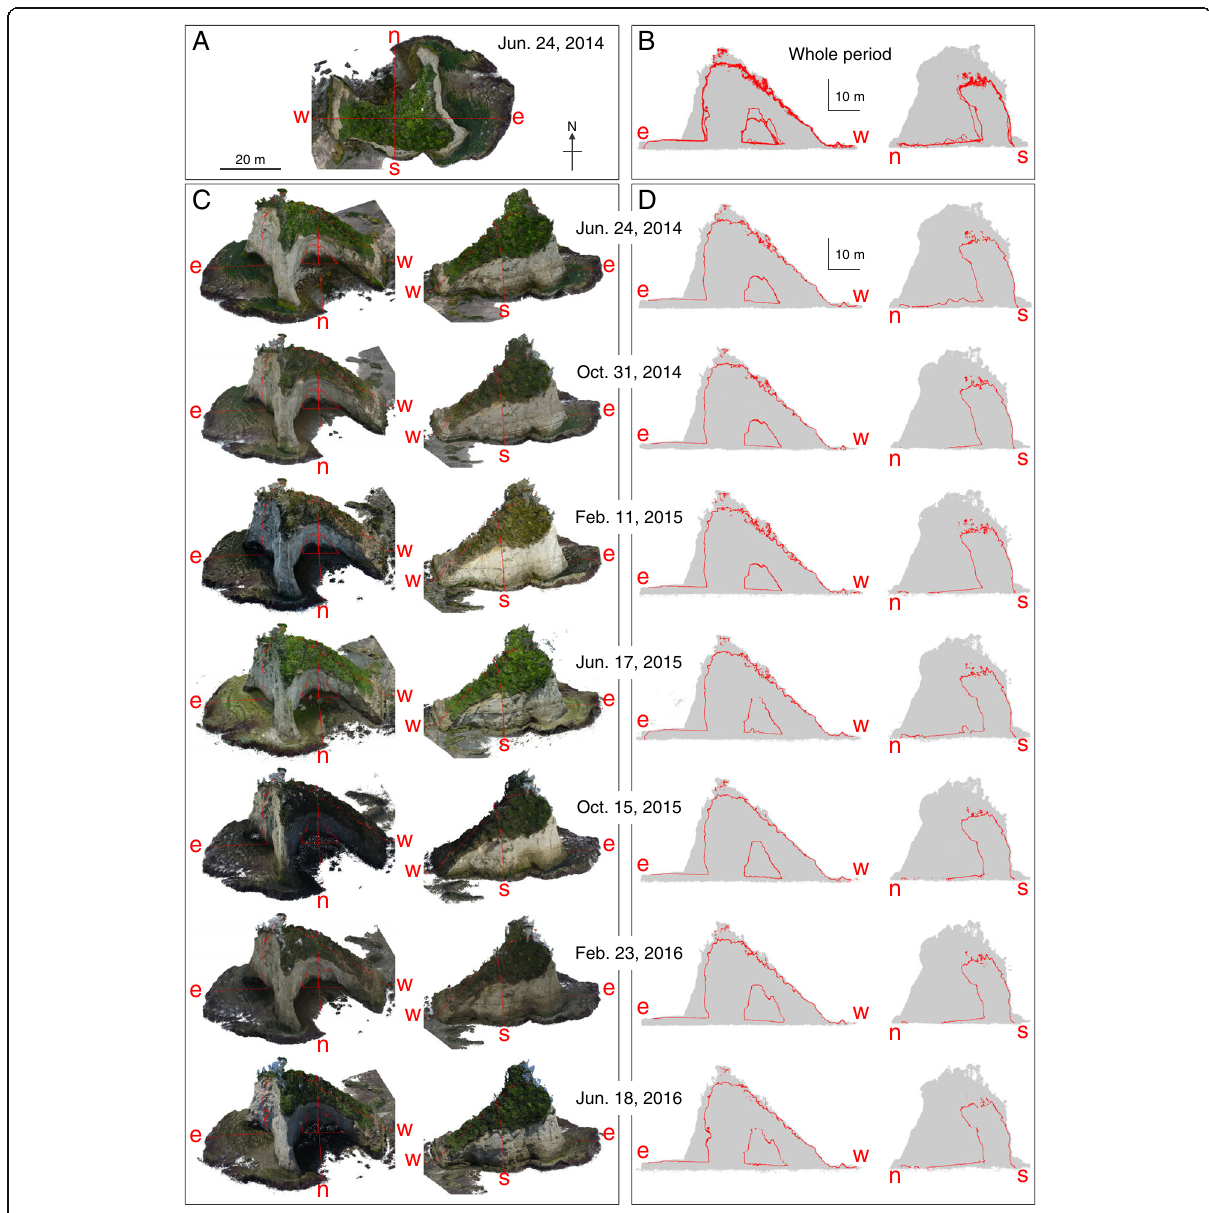
Fig. 3 3D models ( a , c ) and cross sections ( b , d ) of Suzumejima from June 24, 2014, to June 18, 2016. a Viewed from the top and c viewed obliquely from above with traverse lines (red lines) of cross sections. Lowercase letters (n, s, e, and w) indicate the directions of traverse lines. The left figures of c are viewed from the north, and the right figures are viewed from the south. b Superimposed cross sections of all periods ( d ). The left figures of d show cross sections of an east-west orientation, and the right figures show cross sections of a north-south